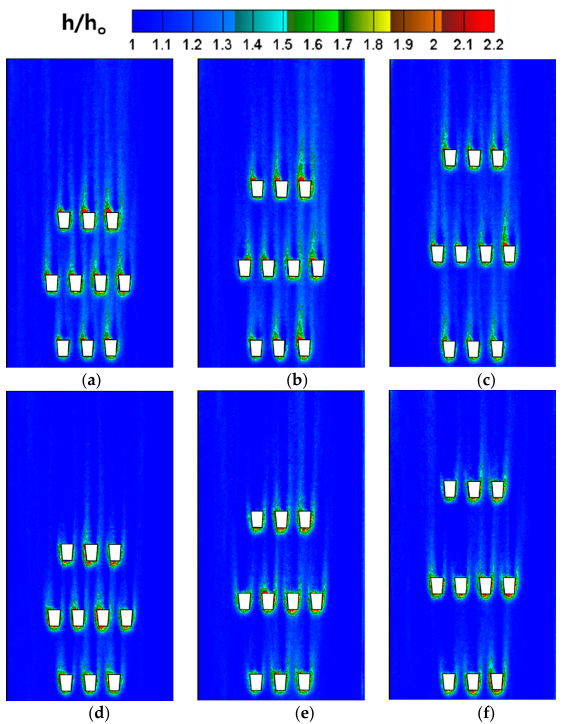
Figure 10. Distribution of h/h o for different row-to-row distance cases: ( a ) L/D = 20, M = 1.0; ( b ) L/D = 25, M = 1.0; ( c ) L/D = 30, M =1.0; ( d ) L/D = 20, M = 2.0; ( e ) L/D = 25, M = 2.0; and ( f ) L/D = 30, M = 2.0.